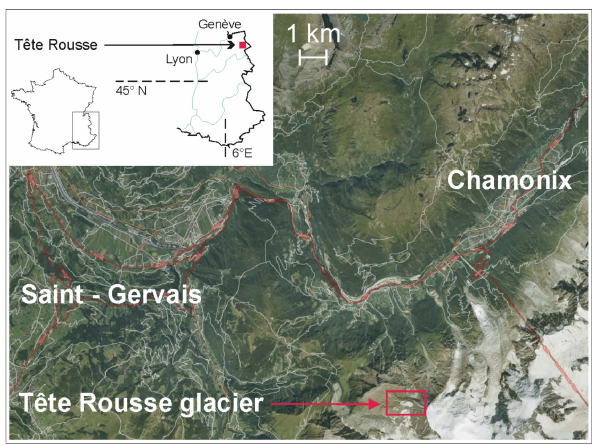
Fig. 1. Location of the Tête Rousse